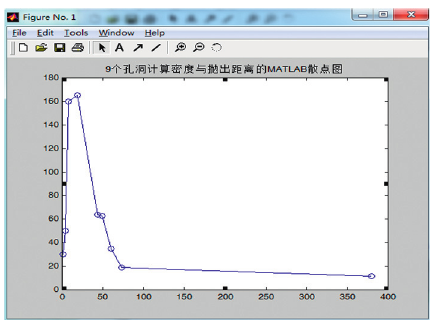
Figure 12: Matlab point line diagram of 9 points. Table 6: Linear transformation.